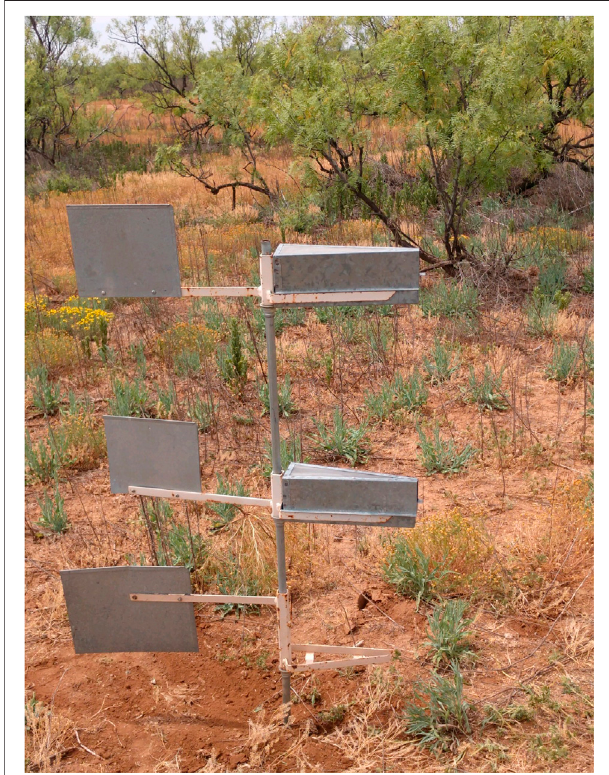
FIGURE 2 | The Big Spring Number Eight dust traps that were used to collect airborne eDNA in this